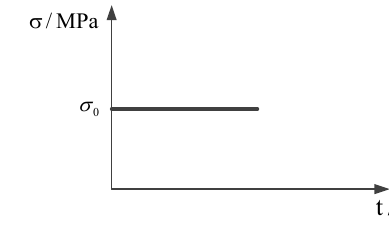
Figure 15. Applied load and time. Coatings 2018 , 8 , x FOR PEER REVIEW